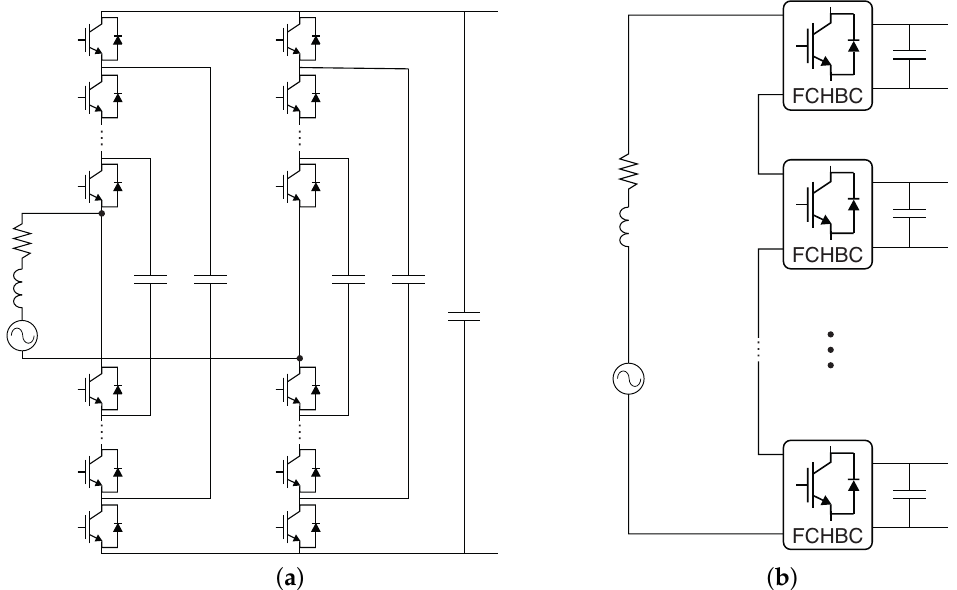
Figure 18. Examples of the most investigated AC/DC converter topologies (FCC). ( a ) Single-phase N-level FCC (adopted in [58]), ( b ) FCC in a modular configuration (adopted in [59]).